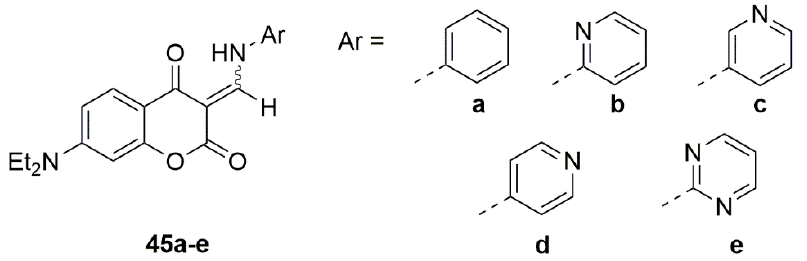
Figure 18. ( A ) Two-dimensional LDA score plot for the analysis of probes 45a – e binding 10 divalent metal chlorides. ( B ) A three-dimensional LDA score plot captured 90% of all information available from the pattern recognition system, significantly improving on the separation of difficult cases that were imperfectly discriminated, using the two-dimensional results. Confidence ellipsoids were drawn at 95% confidence. Adapted from [218] with permission from The Royal Society of